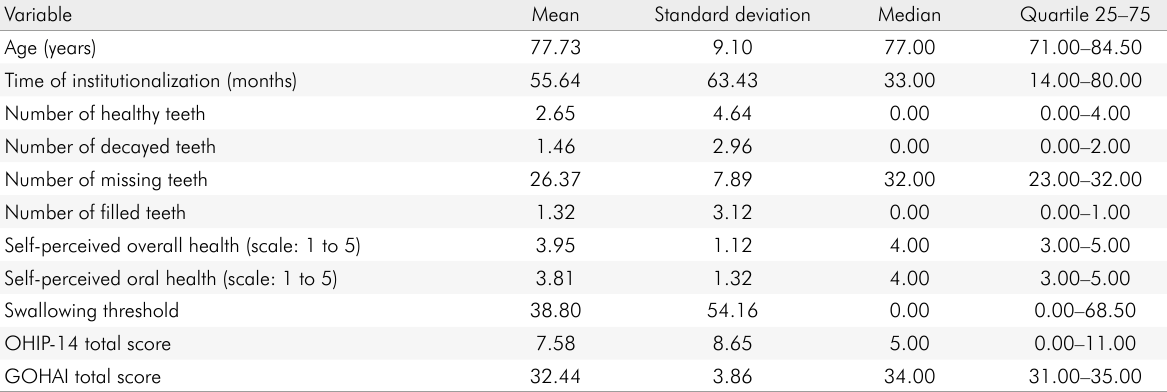
Table 2. Descriptive of the quantitative variables included in the